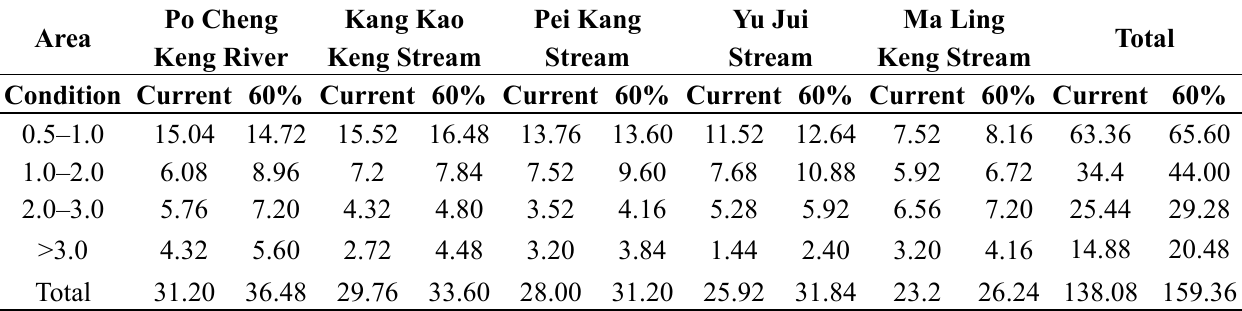
Table 4. The entire area’s flood area vs. the level of development for the 25-year return period.